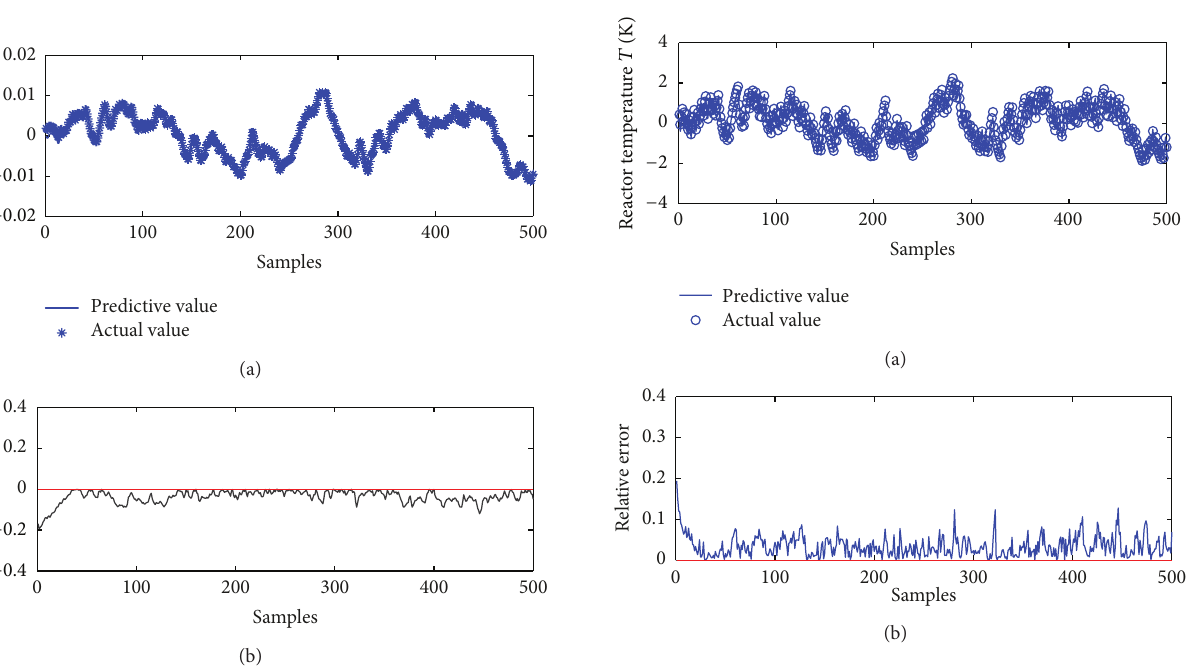
Figure 7: Reactor temperature prediction result and relative error under reactor flow rate 𝐹 𝑐 action.